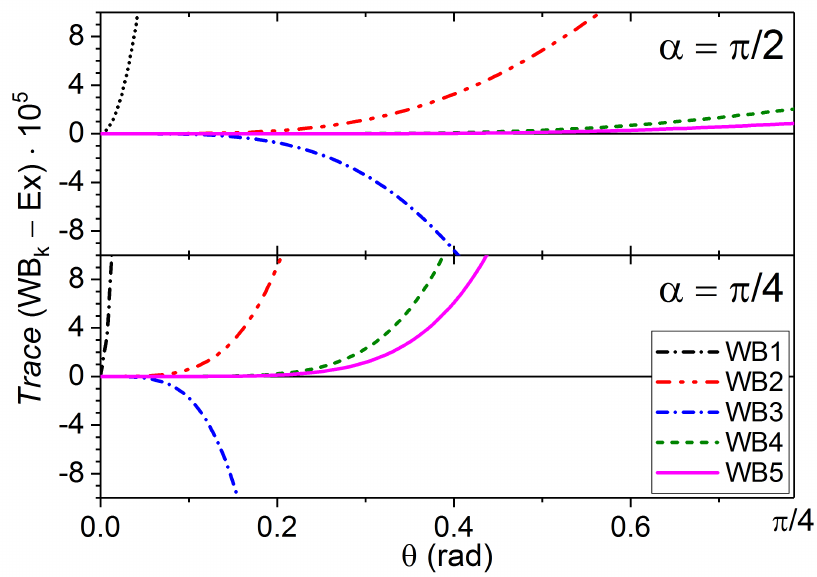
Figure 4. Error in the approximations to the matrix trace as a function of the rotation angle θ , for two values α = π /2 and π /4.